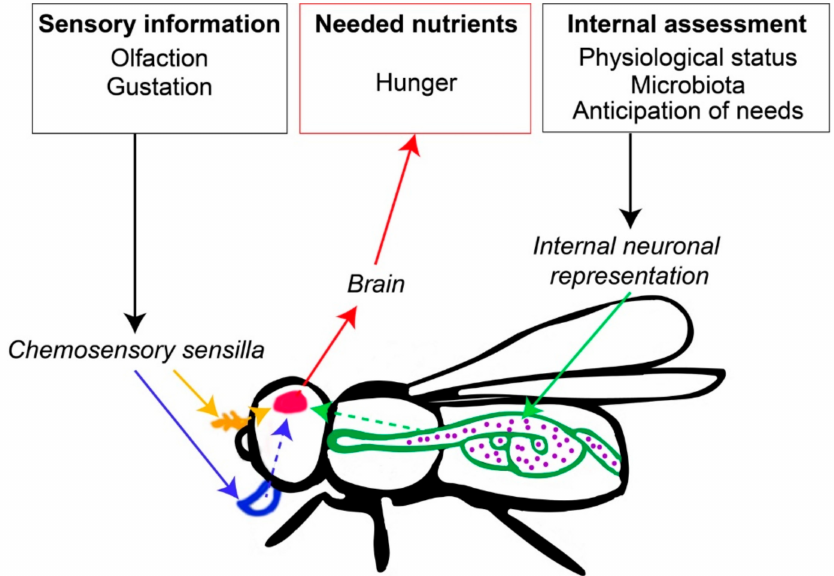
Figure 1. Basic neurophysiological processes involved in nutritional decision making. External sensory information is perceived by chemosensory sensilla involved in olfaction and gustation. Internal assessments of nutritional needs are detected by receptors and information is carried by neurons that relay physiological status, future needs and information from microbiota and from hemolymph. External and internal signals are transferred to the brain that integrates information to generate a hunger toward a specific nutrient. This information encodes the need for this